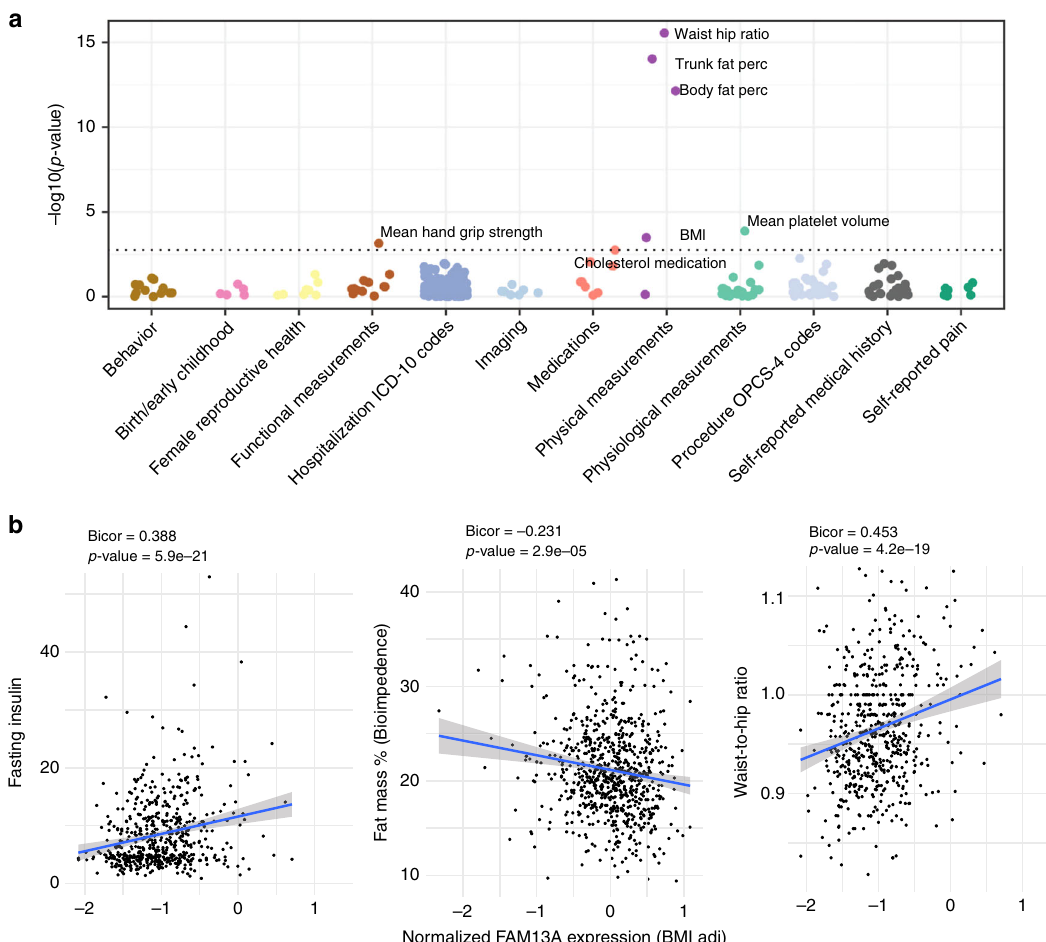
Fig. 2 PheWAS analysis of FAM13A variants. a Phenome-wide association analysis of the variant rs1377290 (used as a proxy for fi nemapping lead variant rs9991328, LD R2 1.0) performed in ~337 K individuals in the U.K. Biobank shows associations with metabolically related phenotypes, including body fat and trunk fat percentage. Associations signi fi cant at 10% FDR are labeled. b In male subjects in the METSIM cohort, normalized FAM13A expression in subcutaneous adipose tissue (adjusted for BMI) shows a positive correlation with fasting insulin and waist-hip-ratio, but a negative correlation with bioimpedance measured fat percentage. Two-sided t -tests were used in cis-eQTL (Fig. 4h), indicating a potential role of Fam13a perturbation in driving a shift of fat deposition away from visceral depots.